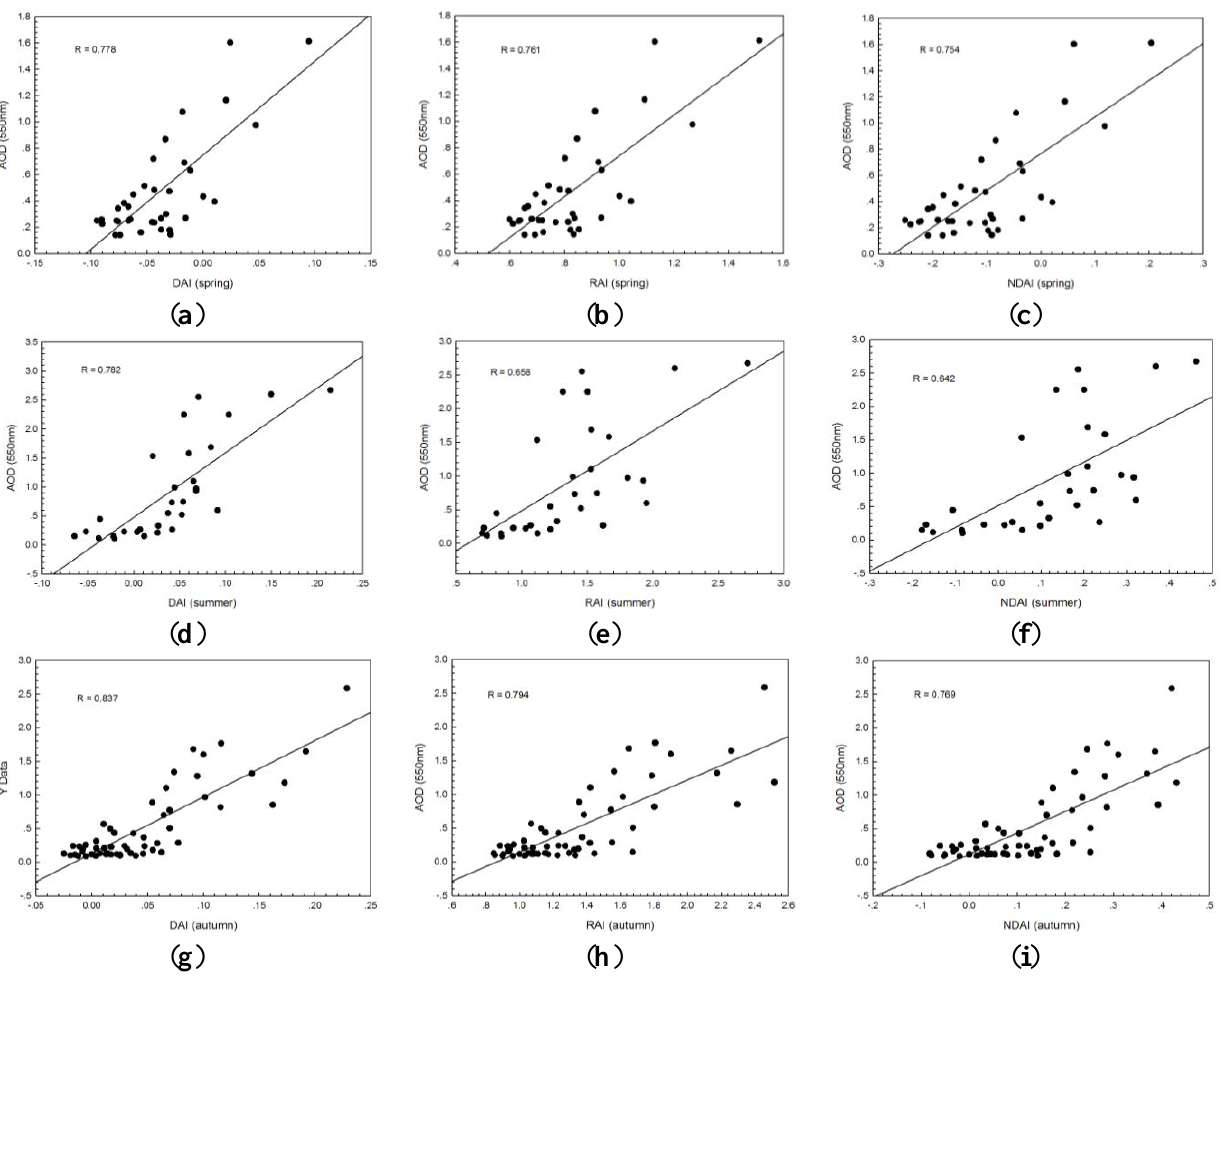
Figure A3. Regression results of the three proposed aerosol indices (DAI, RAI, NDAI) against AOD (550 nm) as observed at the Xianghe station. ( a – c ) spring; ( d – f ) summer; ( g – i ) autumn; ( j – l )